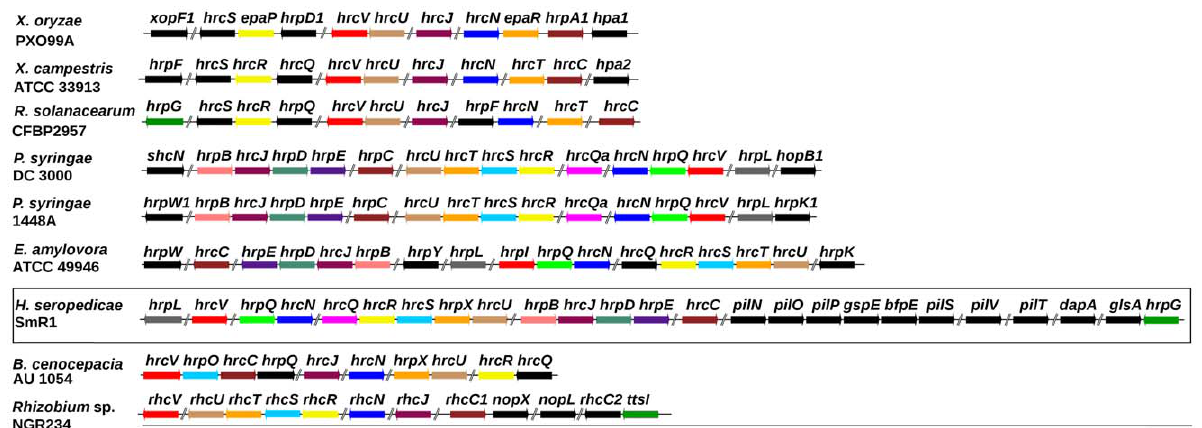
Figure 2. The type III secretion system gene cluster of H.seropedicae SmR1 and other organisms. Genes of the same color in different organisms are homologous. Genes colored in black have no counterpart in the genomic regions